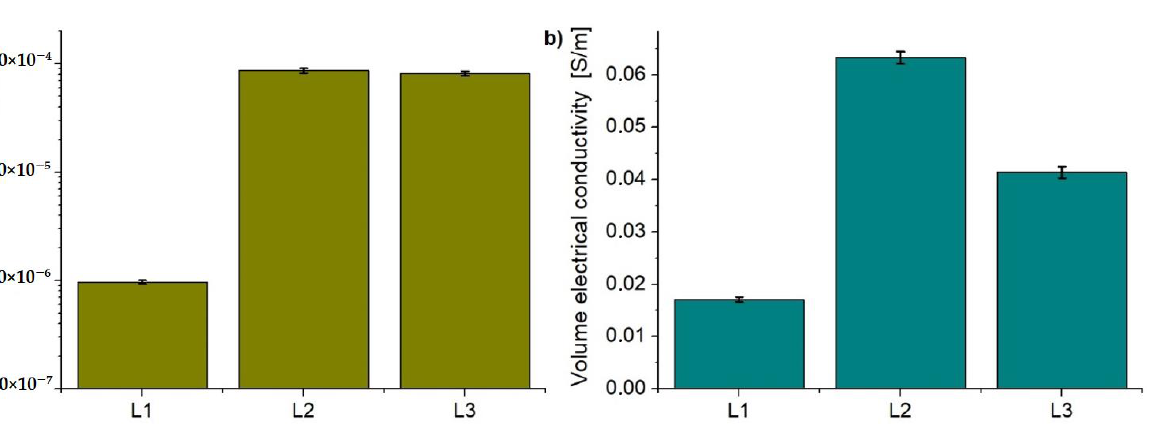
Figure 6. Electrical conductivity of CFRP panels: ( a ) surface, ( b ) Z-direction (through the thickness).